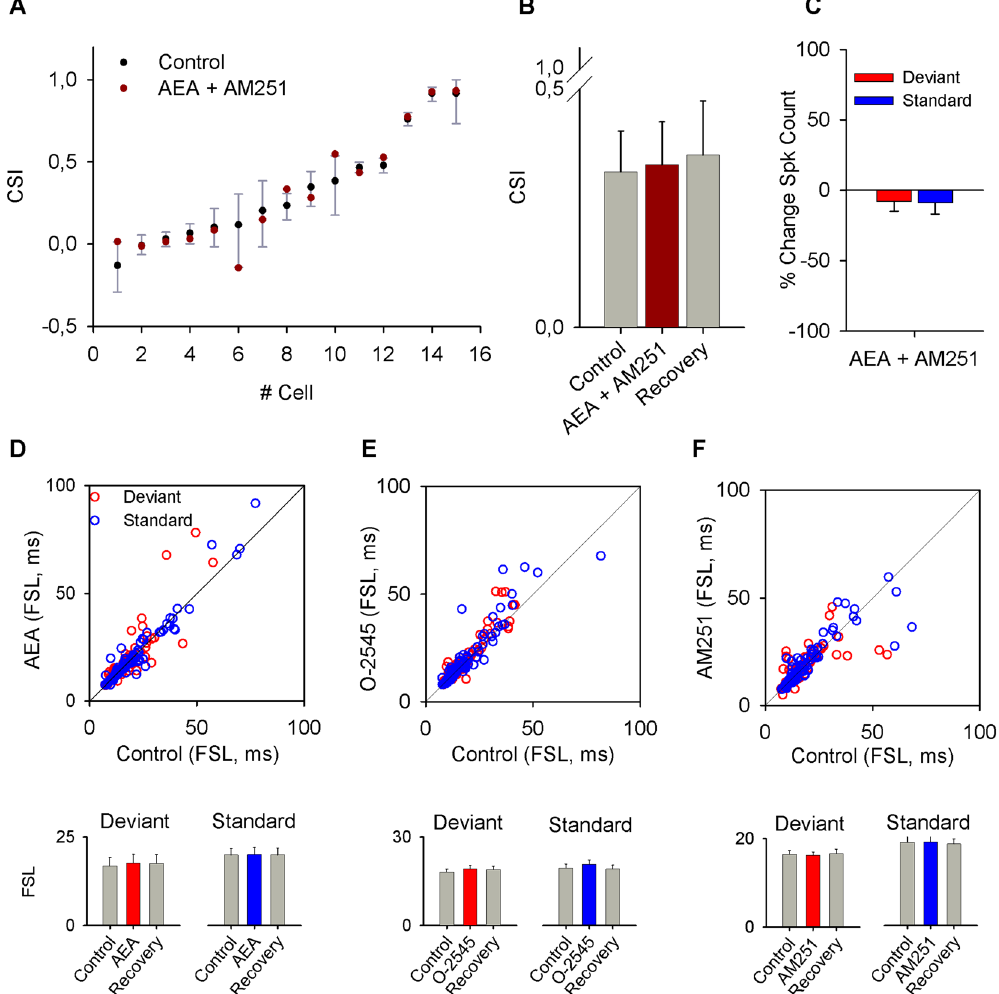
Figure 5. Effects of the co-application of AEA and AM251. ( A ) Bootstrap analysis of the effect of the combination of agonist plus antagonist showing that co-application did not produce effects on the CSI of the IC neurons. ( B ) Bar graph representation of the effect of the combination of drugs on the average value of CSI. ( C ) Percent change of the spike count in response to standard and deviant frequencies after application of agonist plus antagonist. ( D – F ) Scatter plots that represent the FSL in control condition versus drug application, for AEA, O-2545 and AM251 respectively. Below are bar plots of the average values of FSL for deviant and standard stimuli in control condition, with drug application and during